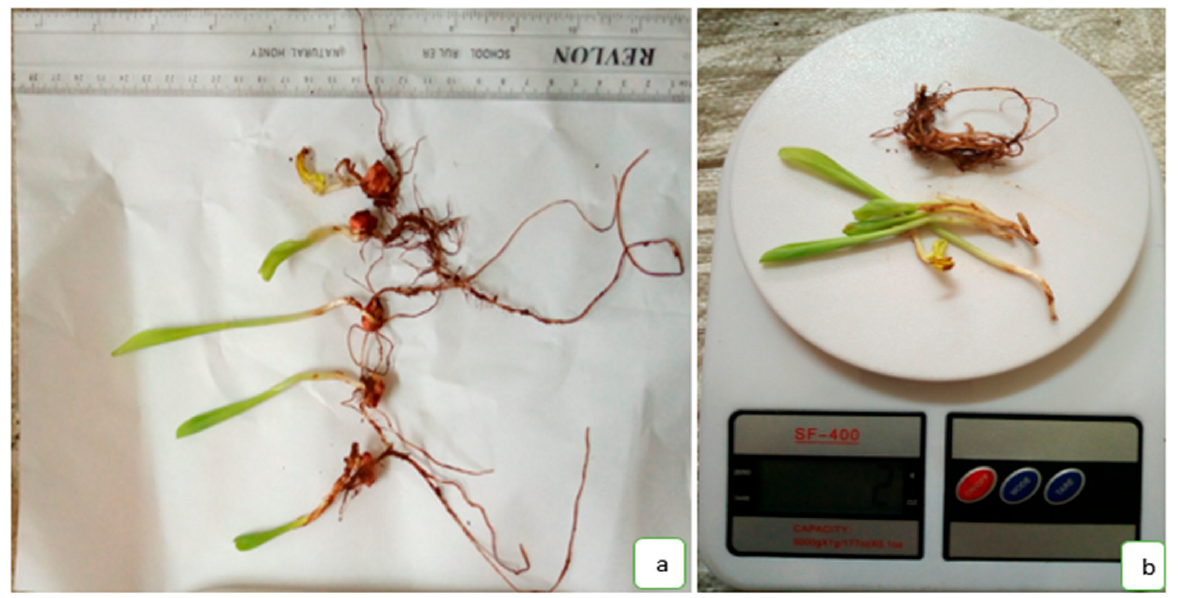
Figure 3. Seedlings vigor parameters; measuring ( a ) seedling height and ( b ) seedling weight.